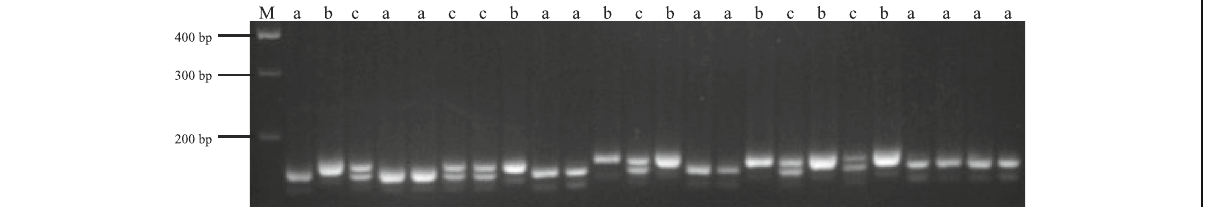
Fig. 4 BC 5 F 2 plants were screened with InDel-R. M: DNA marker III, a plants lacking the restorer gene Rf1 , b Rf1 homozygous plants Rf1 , c Rf1 heterozygous